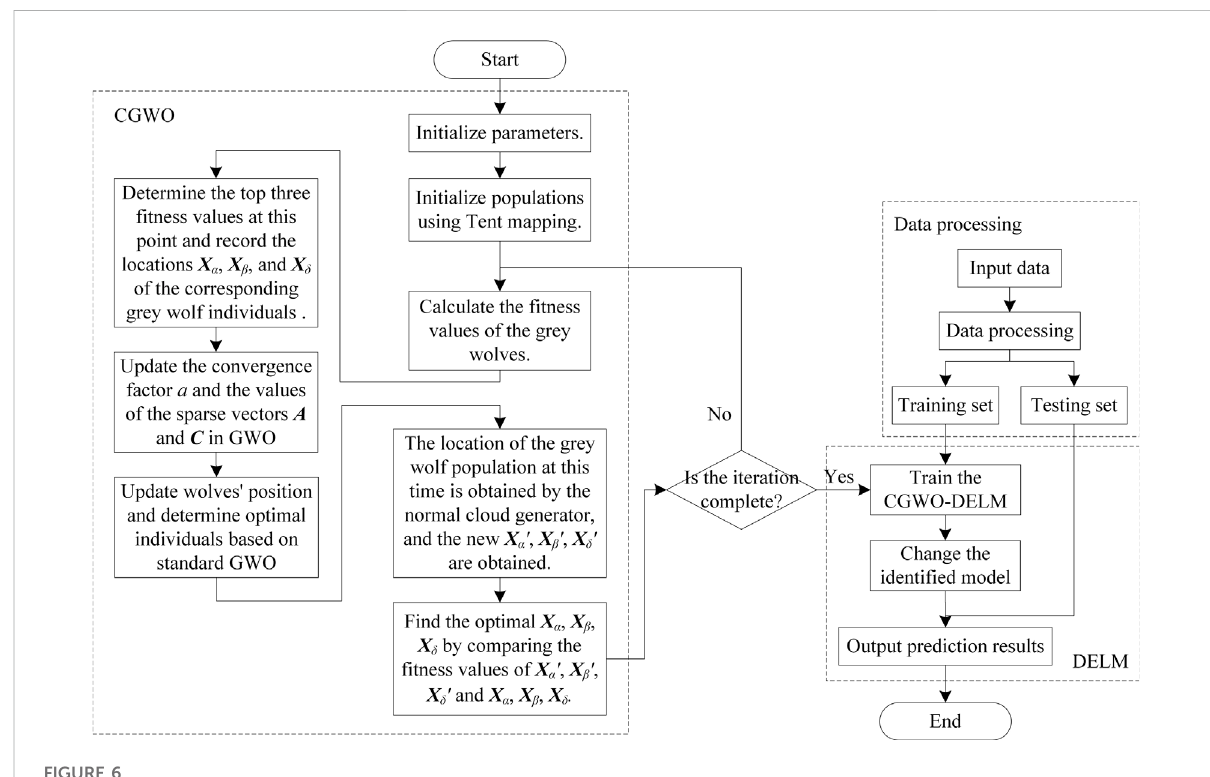
FIGURE 6 Process of